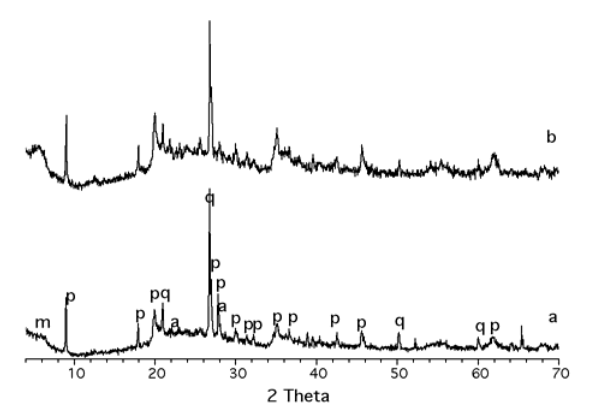
Figure 1. XRD of acid treated montmorillonites: (a) K10; (b) K30. m = montmorillonite (PDF 76-0928); a = albite (PDF=41-1480); q = quartz (PDF 3-0015); p = phengite 2M 1 (PDF